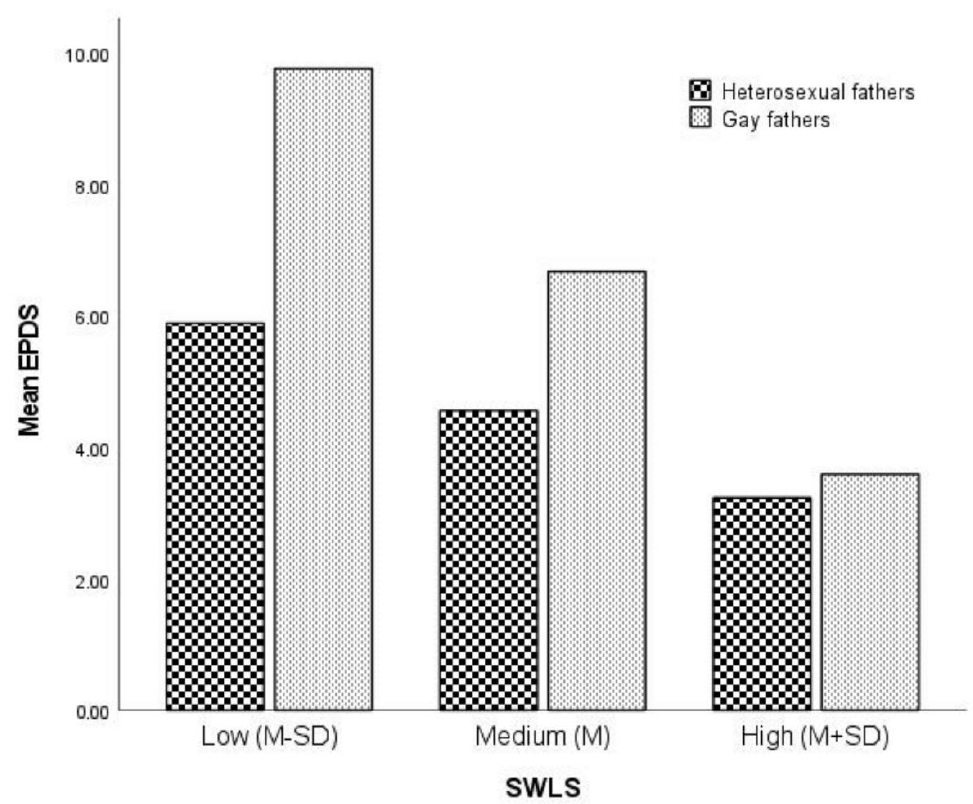
Figure 2. Group by satisfaction with life (SWLS) interaction affecting Edinburgh Postnatal Depression Scale (EPDS). Simple effects were evaluated at SWLS = 4.30 (low), 5.30 (medium), and 6.20 (high).